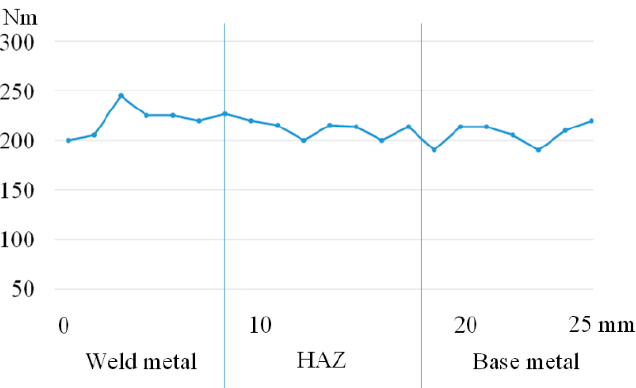
Figure 13. Distribution of microhardness over the cross section of template 2 (see Figure 7).